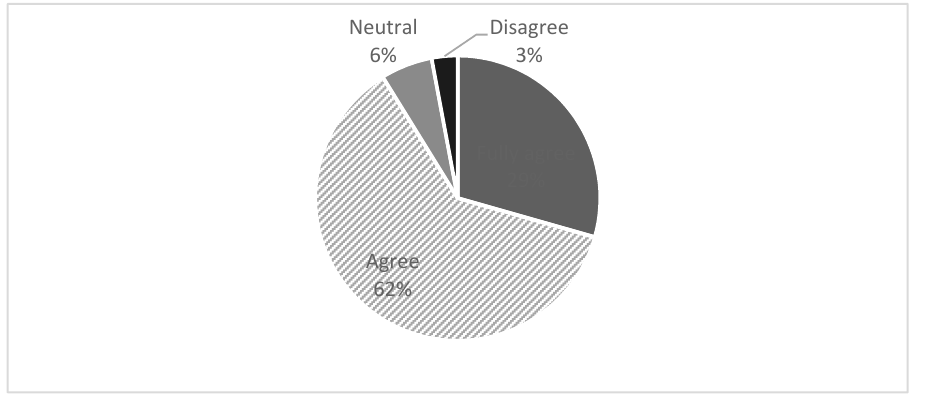
Figure 3. Impact on awareness (answers to the statement ‘As a result of participation, my awareness has increased’).